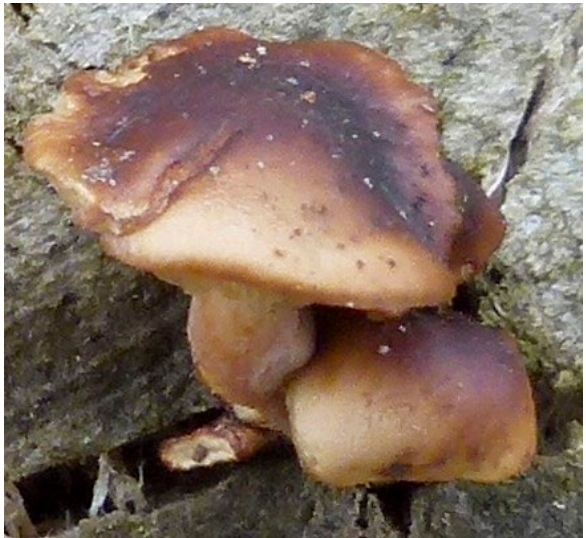
Figure 2. Often fruitbodies of Flammulina velutipes appear in clusters and develop out of cracks in the wood. Photo - graph: M.